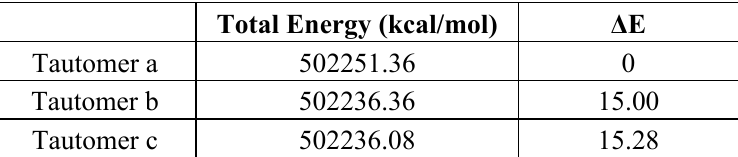
Table 7. Total Energy and relative energy for the four tautomers after single point PCM calculations.